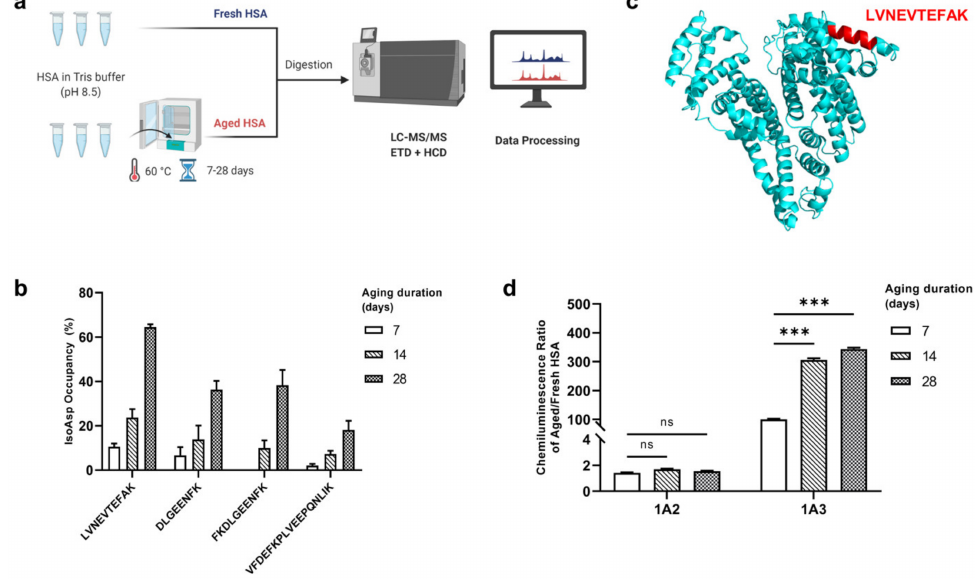
Figure 1. Development of ELISA against isoAsp in human serum albumin (HSA). ( a ) Finding the “IsoAsp meter” peptide for measuring isoAsp in HSA. Artificially deamidated HSA was digested, with the peptides analyzed by LC-MS/MS with ETD and HCD fragmentation and label-free peptide quantification. ( b ) Changes of the isoAsp occupancy in Asn-containing HSA peptides over aging duration. ( c ) Location of the peptide LVNEVTEFAK in the structure of HSA monomer. ( d ) Comparison of the indirect ELISA signals with 1A2 and 1A3 mAbs of HSA aged for 7–14–28 days. Aged HSA was used as a positive control, and fresh HSA as a negative control, while the ratio of these two ELISA signals provided the dynamic range related to mAb specificity, *** p < 0.0001, ns: not significant.